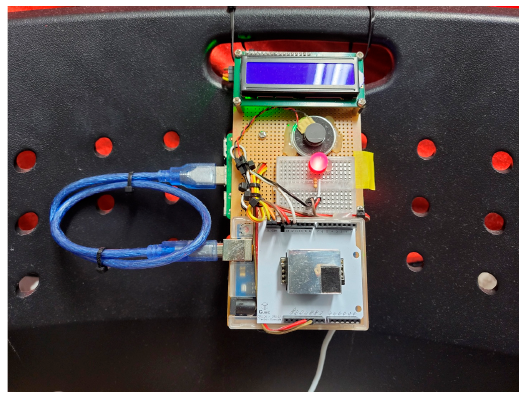
Figure 8. CO (cid:2870) concentration measurement module. Figure 8. CO 2 concentration measurement